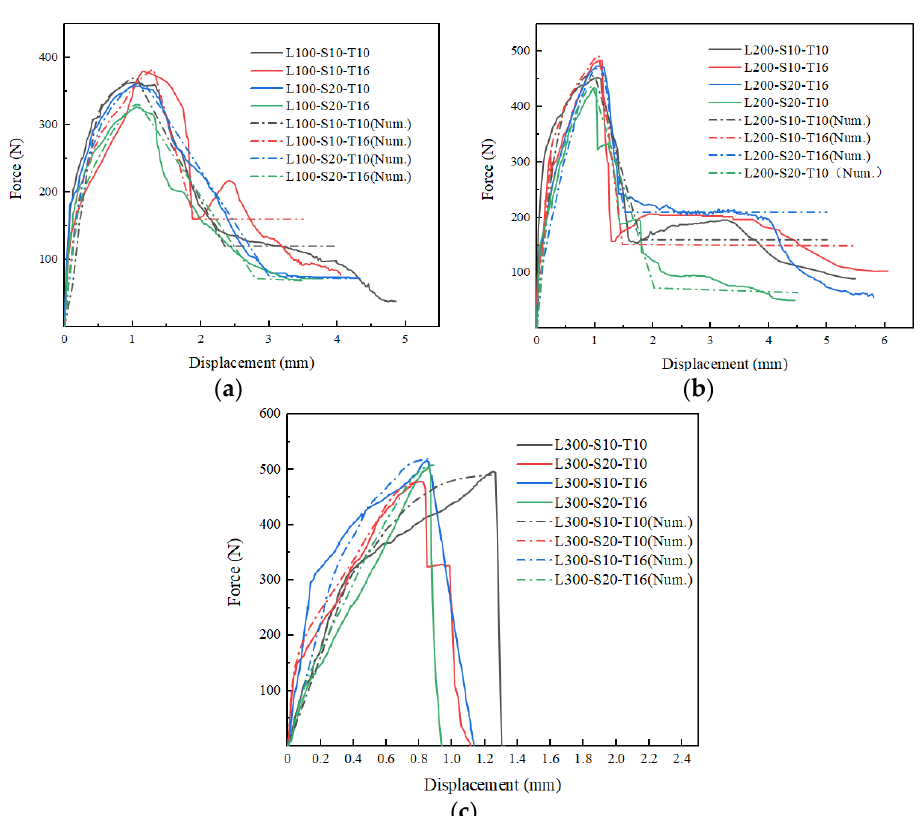
Figure 9. Theoretical curves and experimental curves with the varying development length: ( a ) 100 mm, ( b ) 200 mm, ( c ) 300 mm.